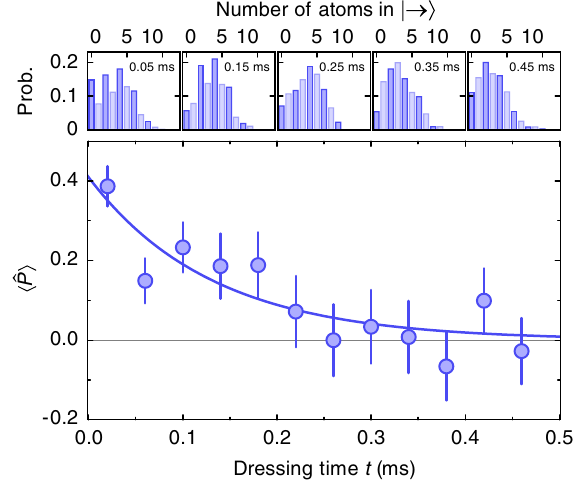
FIG. 4. Evolution of the spin parity in the initially unpopulated j → i state. The histograms on top show the evolution of the number of detected atoms in the j → i state with even numbers highlighted by the darker color. The data were binned in intervals of 0.1 ms and the bin centers are indicated. The main plot shows ˆ P i the extracted parity h vs time, together with an exponential fit with time constant τ P ¼ 0 . 13 ð 4 Þ ms (solid line). All error bars denote one